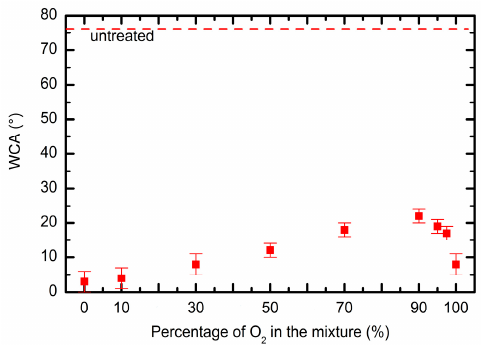
Figure 8. Water contact angles of the PET polymer treated in various SO 2 + O 2 mixtures. Zero percent of O 2 in the mixture refers to pure SO 2 plasma, whereas 100% of O 2 refers to pure oxygen plasma.